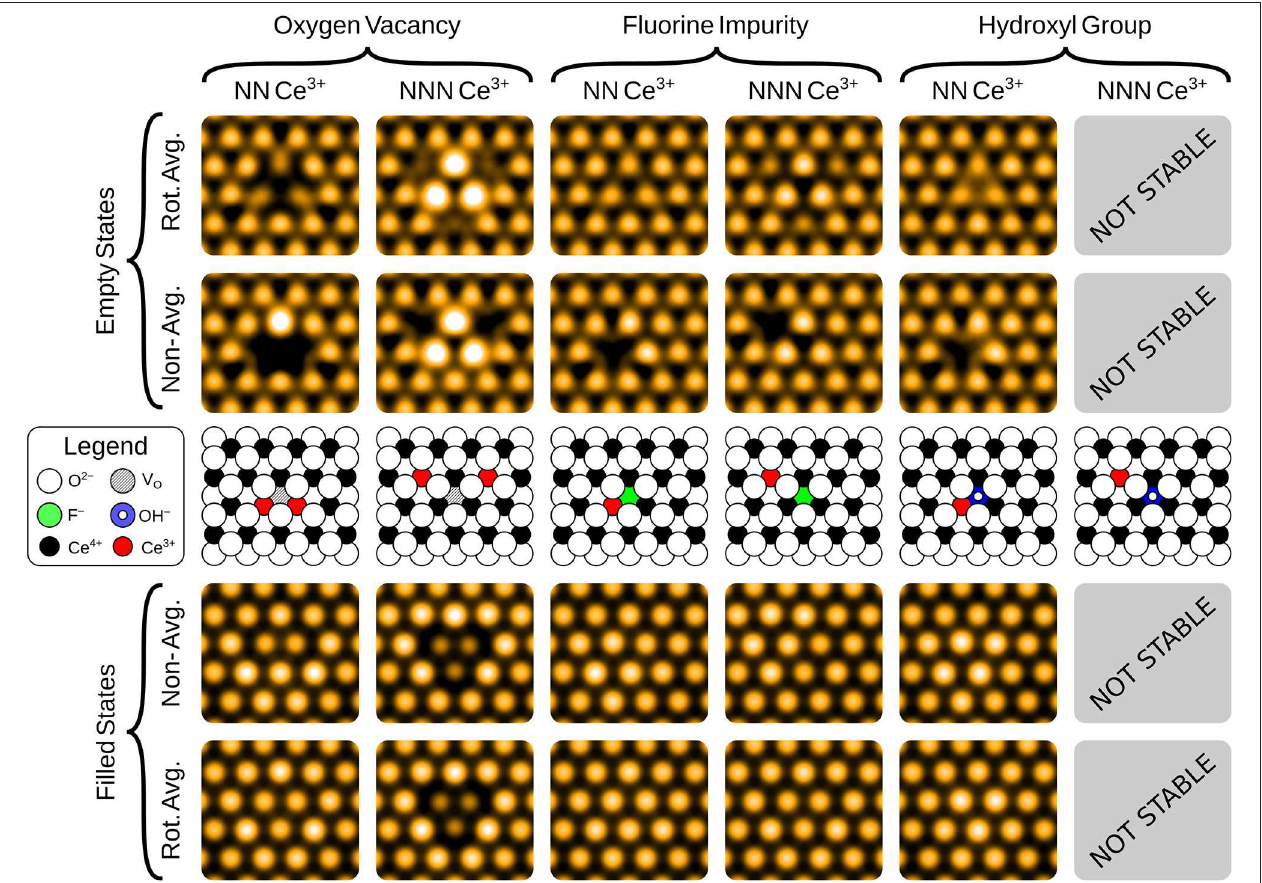
FIGURE 5 | Simulated filled and empty state images of the three sub-surface anionic defects, with the associated Ce 3 + ions at either nearest neighbor (NN) or next nearest neighbor (NNN) lattice sites. The precise locations of the Ce 3 + ions are shown in the schematics, for comparison with the non-rotationally averaged